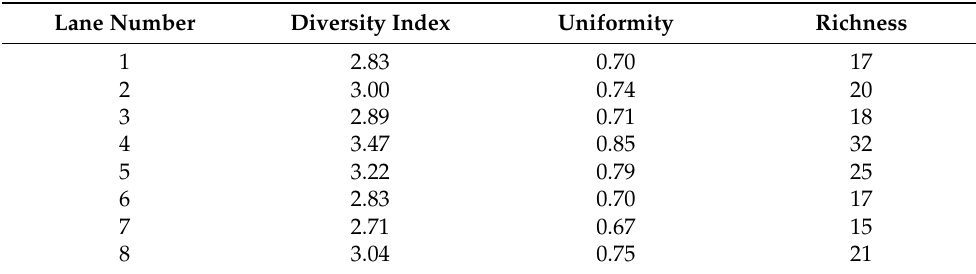
Table 6. Effects of additives on the Shannon diversity index of DGGE profiles of Lolium multiflorum Lam. silage after 60 days of fermentation.